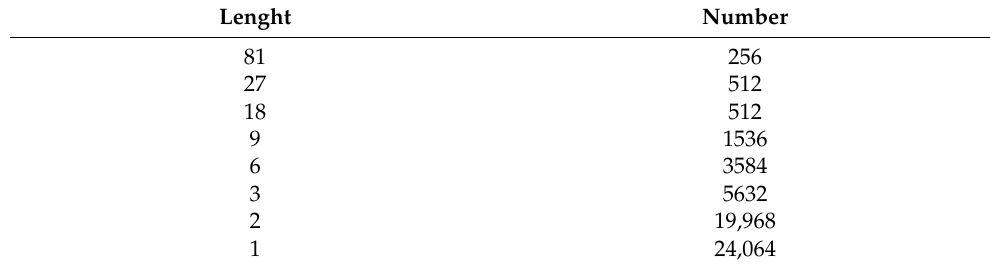
Table 2. The number of segments of a level-4 Menger sponge for each length, in each